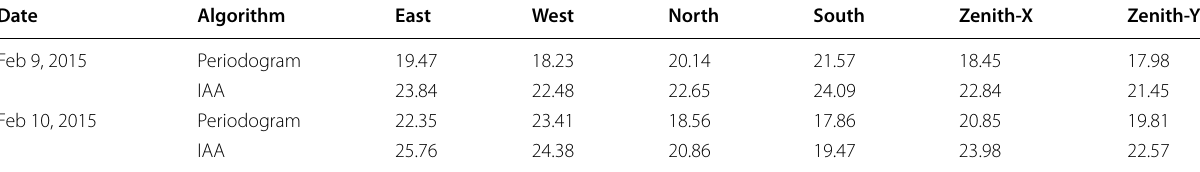
Table 2 Comparison of average SNR for periodogram and IAA algorithm